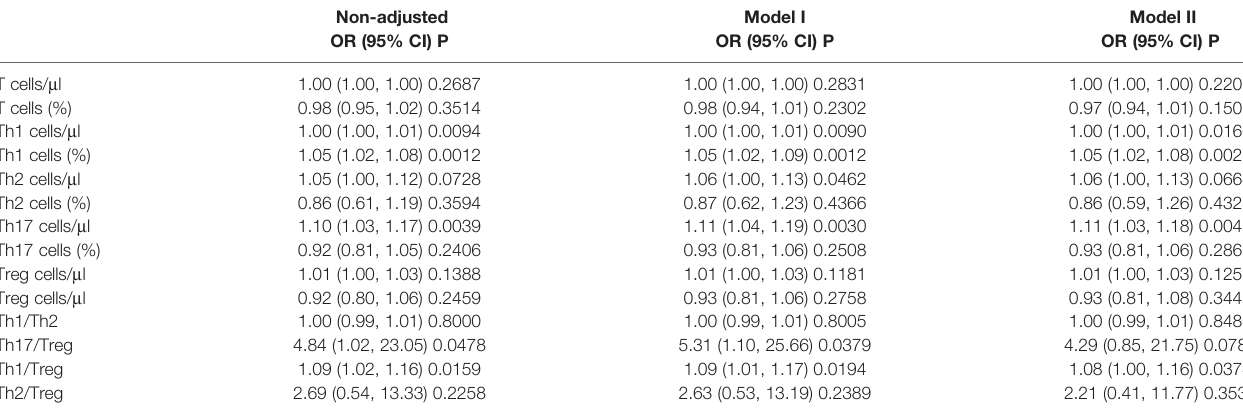
TABLE 4 | Univariate and multivariate analyses of factors associated with RA-AF.